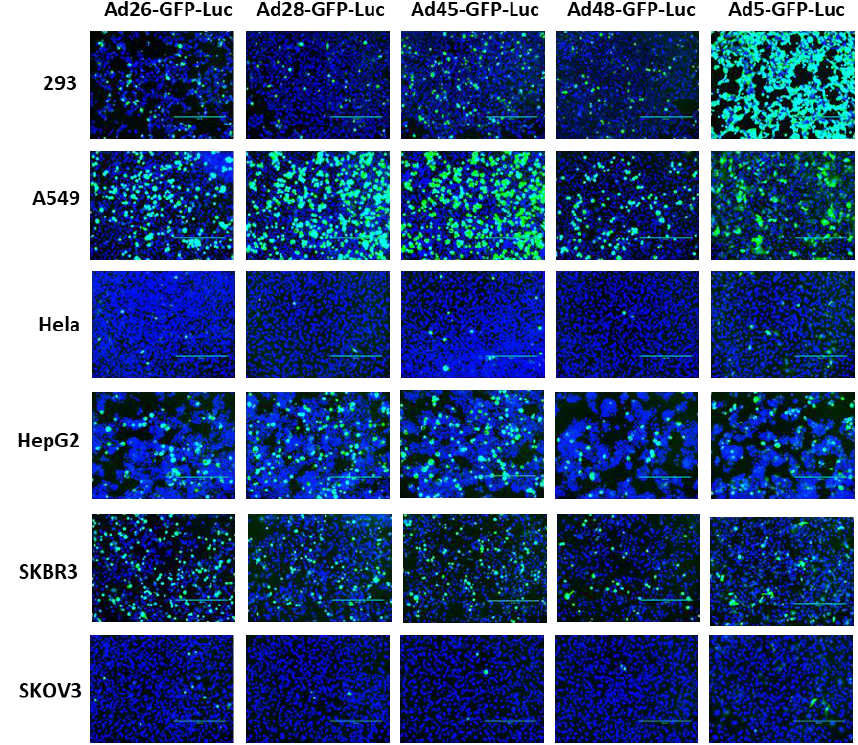
Figure 2. GFP gene expression of the recombinant species D viruses and Ad5 in six cancer cell lines. Each cell line was infected with 500 vp/cell of the indicated species D Ad-GFP-Luc virus and fluorescent images of GFP expression were taken at 24 h post-infection at 10× magnification. The GFP image was overlayed with the DAPI image using ImageJ to visualize cell confluency.